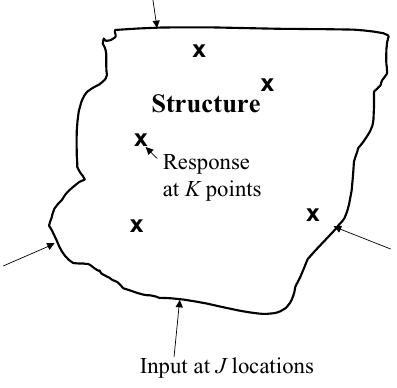
Fig. 1. General multiple-input, multiple-output (MIMO) linear system.